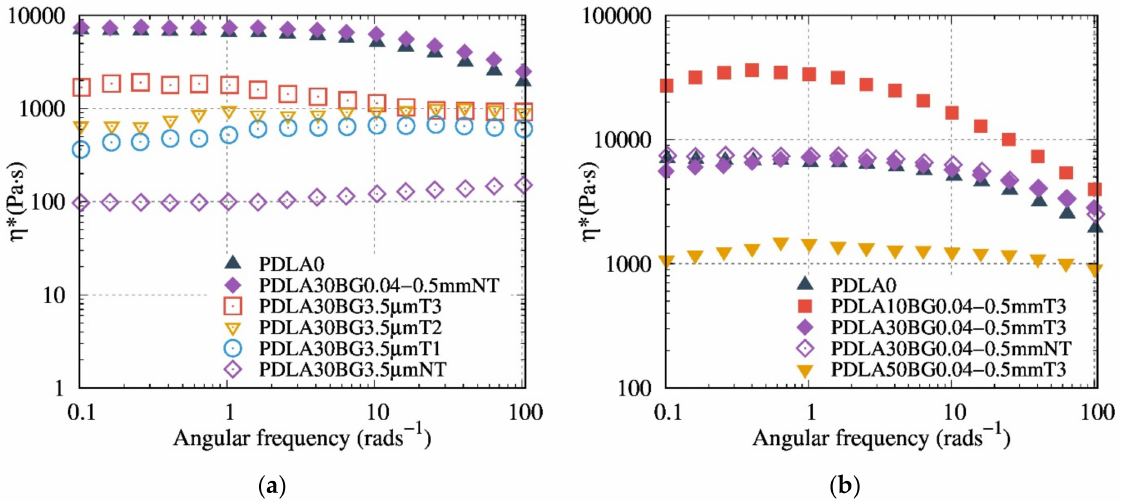
Figure 7. Evolution of the complex dynamic viscosity versus the angular frequency at 150 ◦ C for composites ( a ) with 30 wt% BG as a function of the particle size for NT particles and the thermal treatment of the filler; and ( b ) based on 0, 10, 30 and 50 wt% of 0.04–0.5 mm T3.